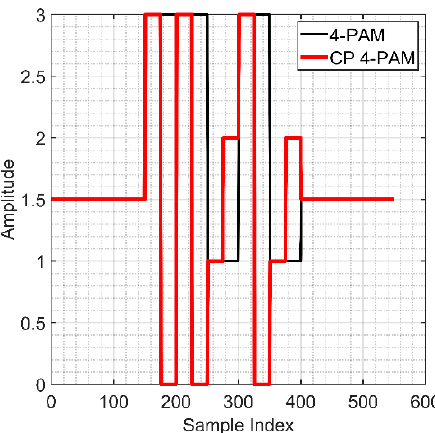
Figure 2. An example of a generated packet signal with 𝑓 (cid:2904)(cid:2934) of 220 Hz.